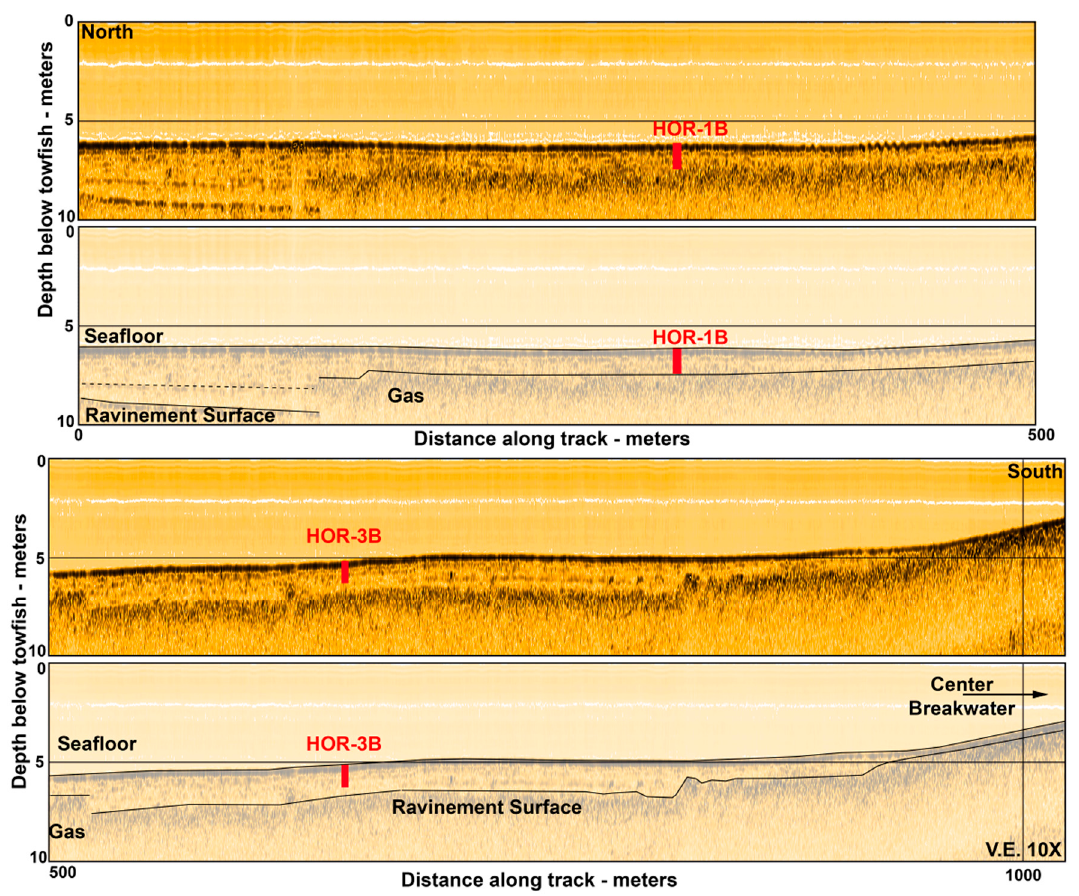
Figure 6. North-northeast to south-southwest trending seismic reflection profile showing the seismic unit overlying the ravinement surface. The seismic profile was collected near the apex of the central breakwater. Red lines show the location and depth of sediment cores HoR-1B and HoR-3B. Note that cores HoR-1-1 and HoR-3-4 were collected in similar locations to HoR-1B and HoR 3-B, respectively. See Figure 1 for the location of the survey line. Vertical exaggeration is 10 × ; di ff erences in the horizontal scale are due to slight di ff erences in vessel speed during the